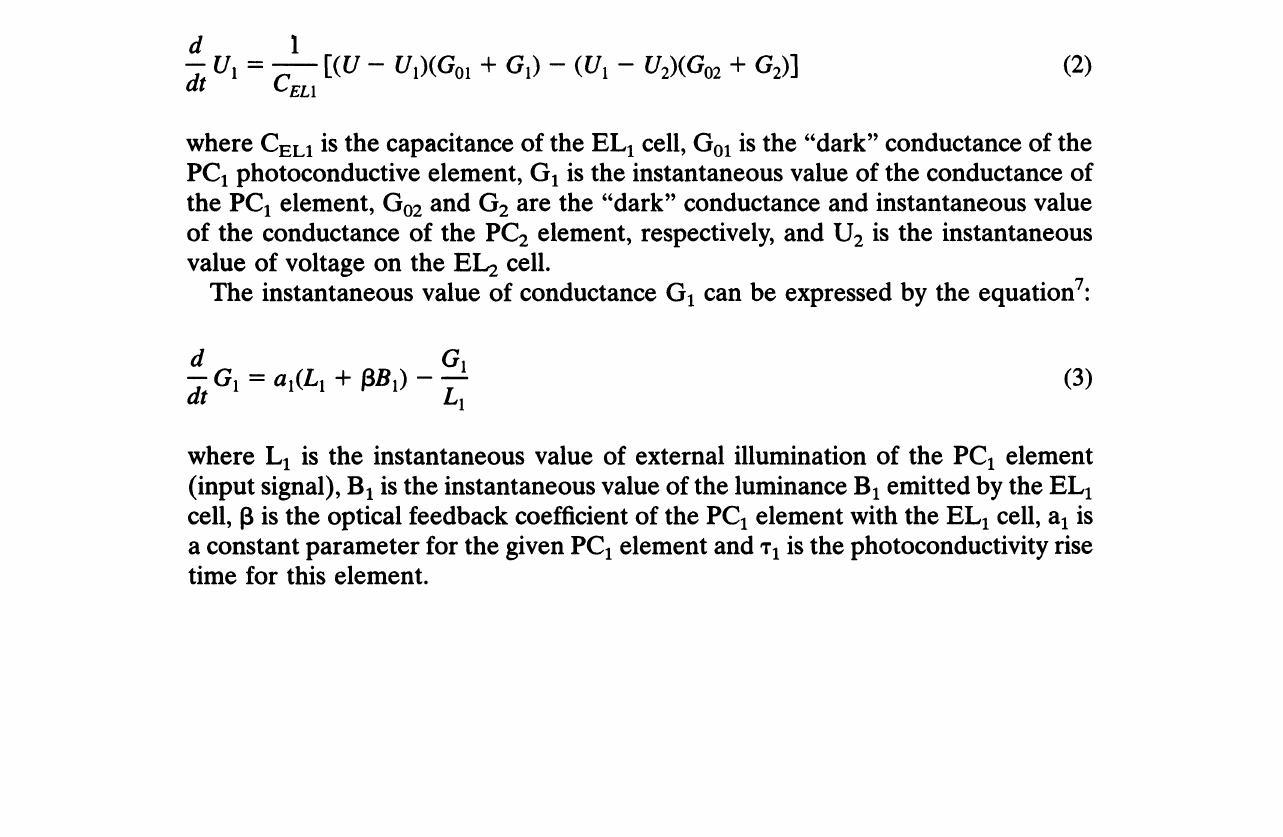
FIGURE 1 Diagram of an optoelectronic memory